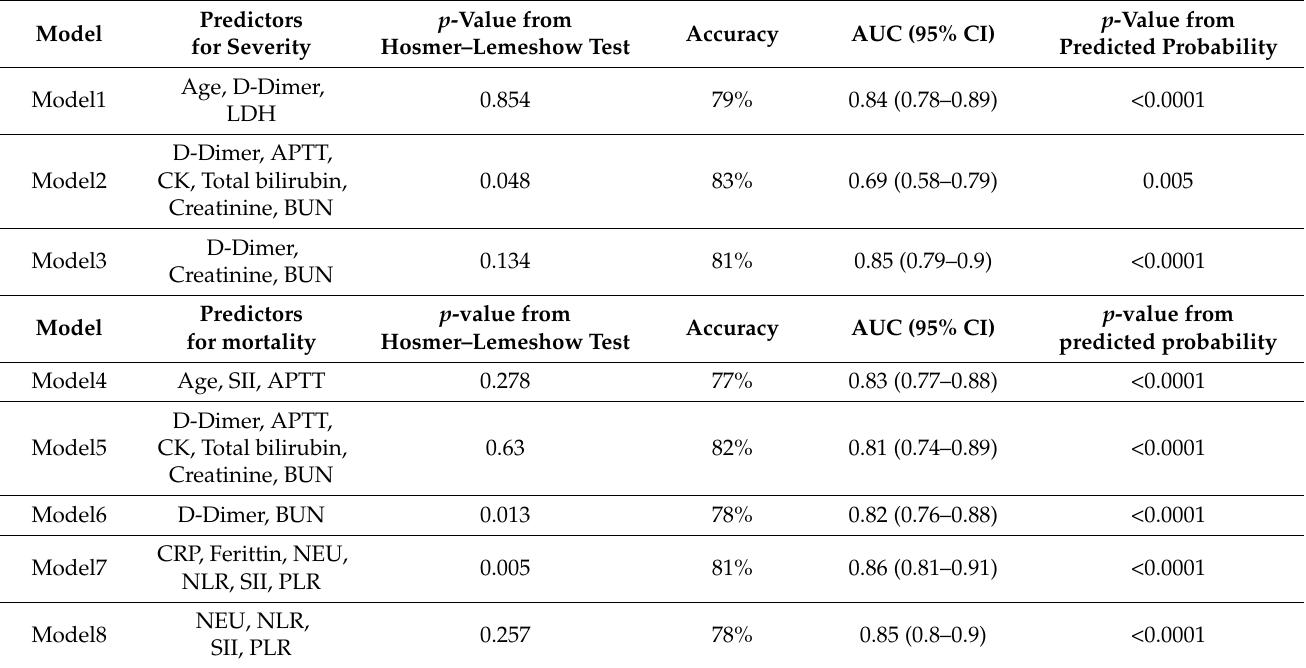
Table 3. Logistic regression analysis of the models of predictors for severity (models 1–3) and mortality (models